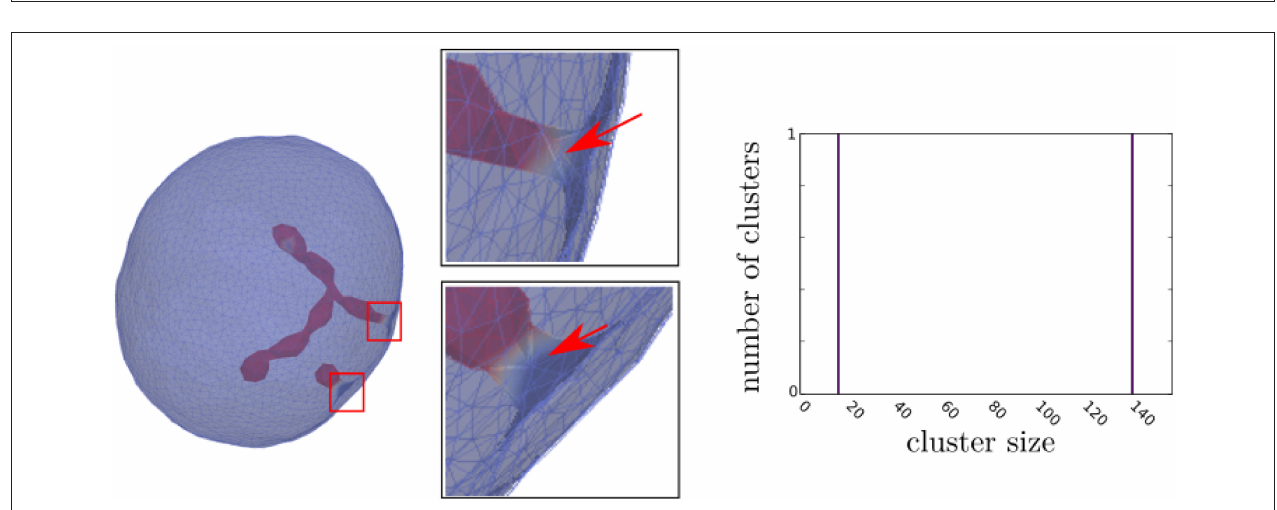
FIGURE 2 | The Monte Carlo simulation of the RBC membrane transformation induced by mobile membrane inclusions with intrinsic curvature c Concentration of membrane inclusions p 5 % . The triangulated membrane surface is drawn semitransparent to uncover its interior shape. Red arrows in enlarged = insets point to the neck area, where there is a lack of inclusions. In the corresponding cluster-size distributions, the y-axis is the ensemble averaged number of inclusion clusters of each size and the x-axis is the inclusion cluster size. The values of other model parameters are: local bending stiffness of lipid bilayer κ and direct interaction parameter w 1.25kT. The parameters for simulations are based on values in [31]. The simulations were run on a personal computer with Intel = i7-7500U processor and 8 GB of RAM; however, the memory requirements for the Monte Carlo simulations are not the limiting factor for the speed of computations. Each simulation was running on a single thread, where simulations with multiple parameter sets were executed on the same processor. The average time for simulations to complete 1,000 time-steps with 100 10 3 mcs each was 14.5 days. After finishing the simulations, the graph of free energy term and asphericity was · ≈ observed to check if thermal equilibrium was